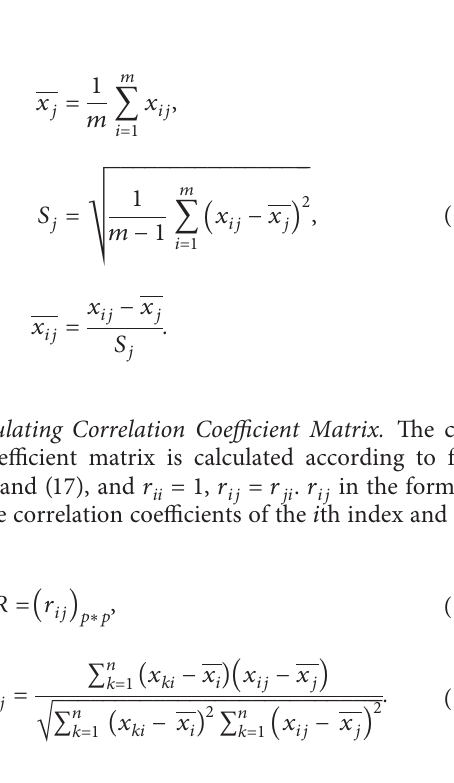
Figure 1: Flowchart of labor market resource prediction model of three major